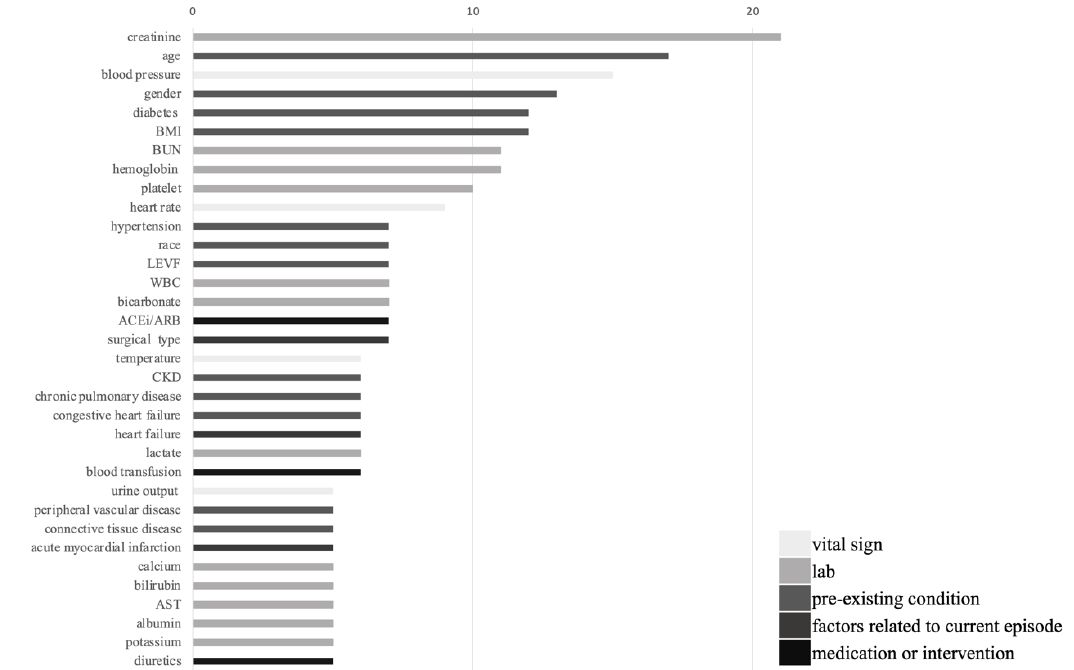
Figure 1. Covariates are most commonly used in machine-learning prediction models in the enrolled studies. The covariates